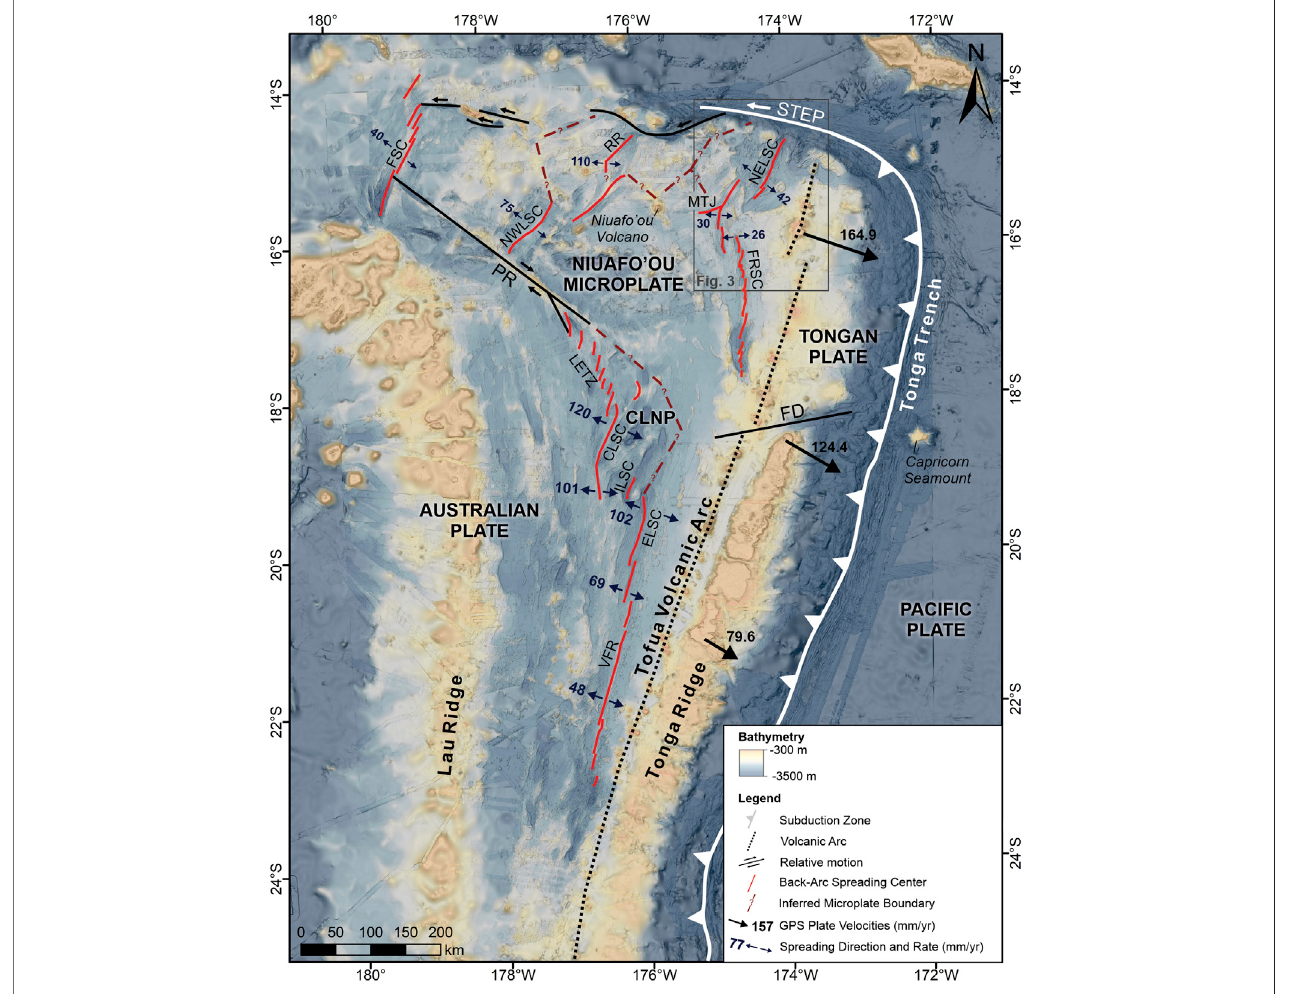
FIGURE 2 | Tectonic features and regional bathymetry of the NE Lau Basin compiled from Rubin and Shipboard Scienti fi c Party (2010), Martinez and Shipboard Scienti fi c Party (2013), Sleeper and Martinez, (2016), Rubin and Shipboard Scienti fi c Party (2018), Haase and Shipboard Scienti fi c Party (2018), and GEBCO Compilation Group (2019). Inferred microplate boundaries based on seismicity from Conder and Wiens (2011), GPS velocities of Tonga relative to Australia from Phillips (2003)andspreadingdirectionsandrates(mm/yr)fortheFSCfromPelletieretal.(2001),fortheNWLSCandRRfromLuptonetal.(2015)followingBird(2003),and for the CLSC, ELSC, FRSC, LETZ, MTJ, NELSC, and VFR from Sleeper and Martinez (2016). CLNP, central lau nano-plate; CLSC, central lau spreading center; ELSC, easternlauspreadingcenter;FD,fonualeidiscontinuity;FRSC,fonualeiriftandspreadingcenter;FSC,futunaspreadingcenter;ILSC,intermediatelauspreadingcenter; LETZ, lau extensional transform zone; MTJ, mangatolu triple junction; NELSC, north-east lau spreading center; NWSC, north-west lau spreading center; PR, peggy ridge; RR, rochambeau rifts; VFR, valu fa ridge.